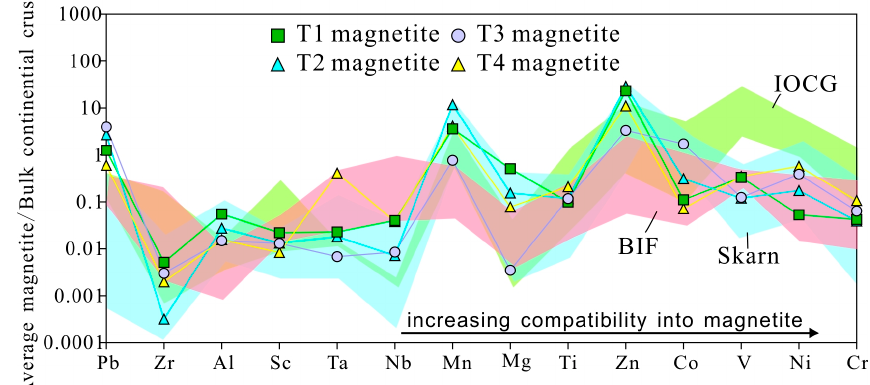
Figure 12. Multi-element diagram for the Heijianshan magnetite, normalized to bulk continental crust. Data for IOCG from the Ernest Henry deposit [30], BIF from the Sokoman Fe formation [60], skarn from the Tengtie skarn Fe [61], and Vegas Peledas calcic skarn Fe [30] deposits are shown for comparison (normalization values from Reference [62]).